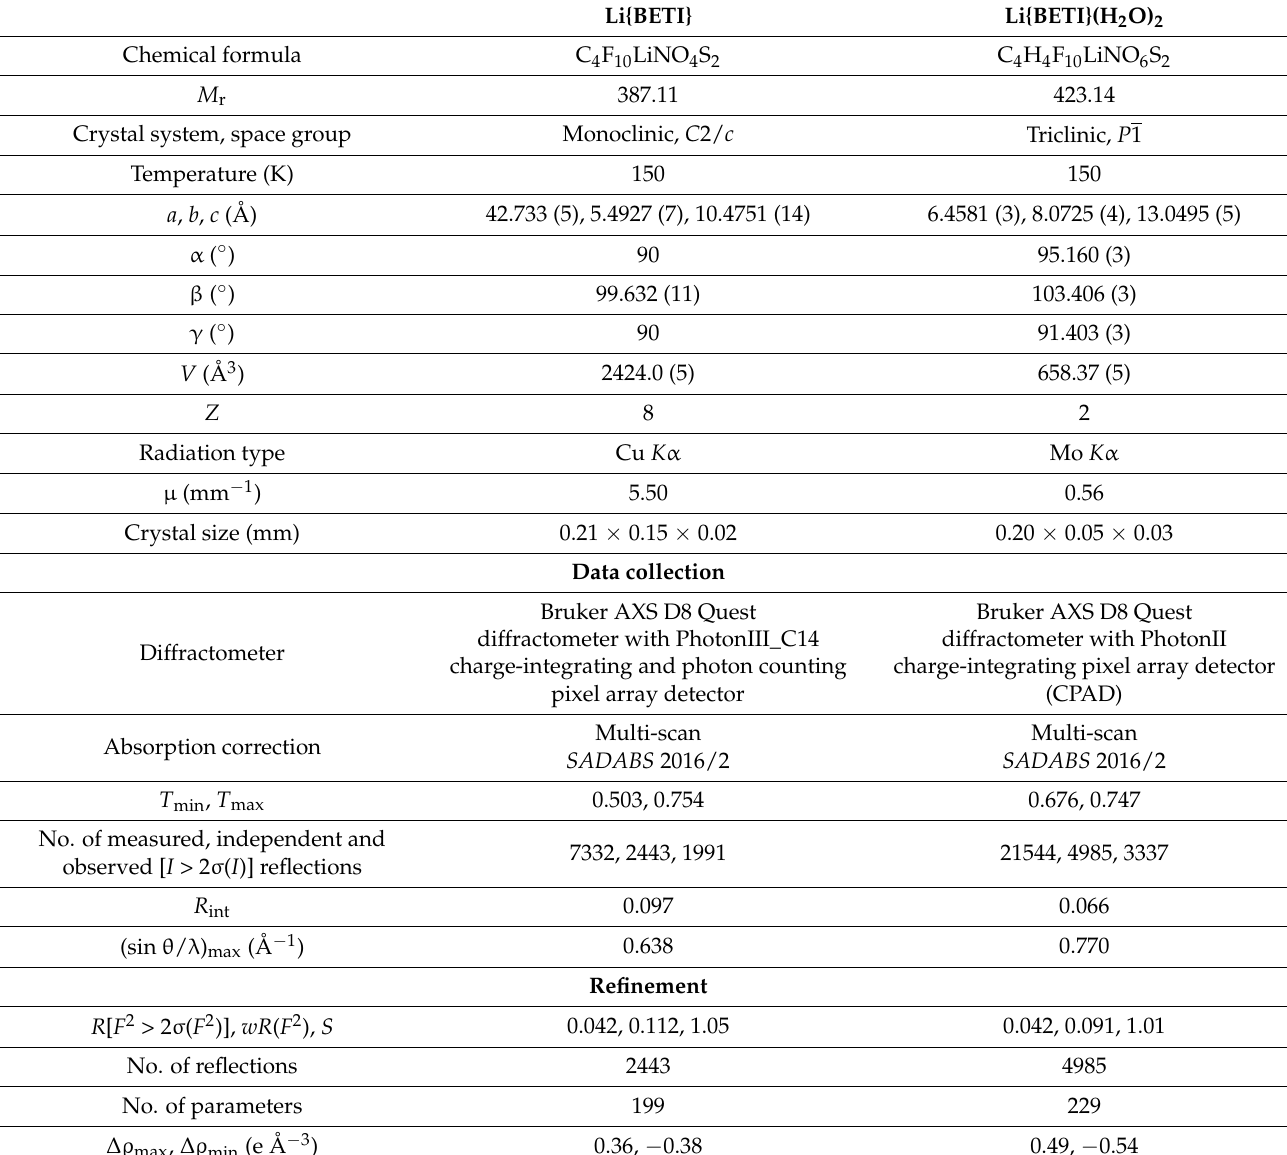
Table 1. Crystallographic data and refinement details for [Li{BETI}] and Li{BETI}(H 2 O) 2